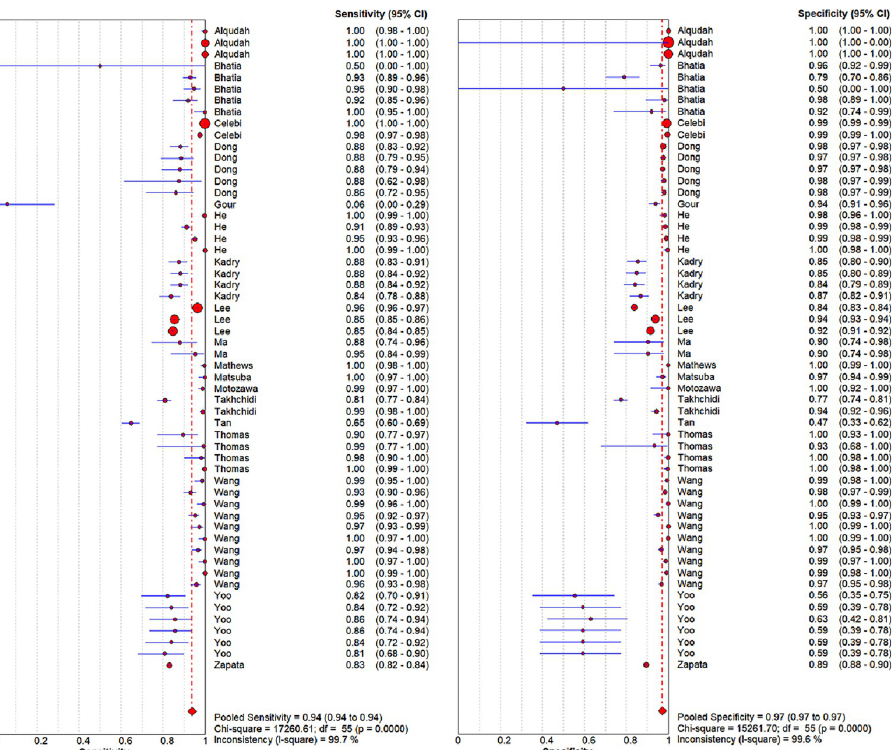
Fig 4. The forest plot of the pooled sensitivity and